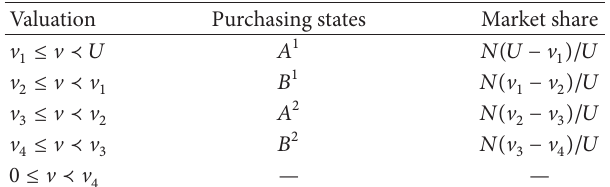
Table 2: Consumers’ preferences and the market shares in terms of